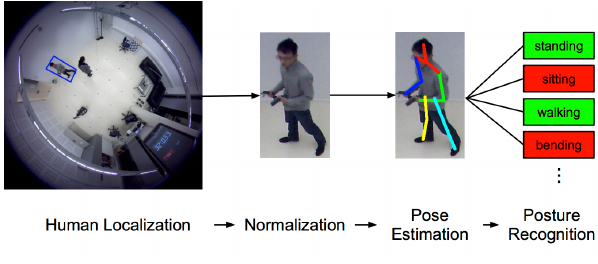
Figure 10. An overview of the posture recognition system. After the humans are detected by the second task, we project the 3D location back to the image space, and we generate the bounding box of the human based on the template. All human images are then rotated to the upright orientation. Pose estimation is applied to generate a set of body part locations in together with a confidence value. Human postures are recognised by classifying on these confidence values instead of body part